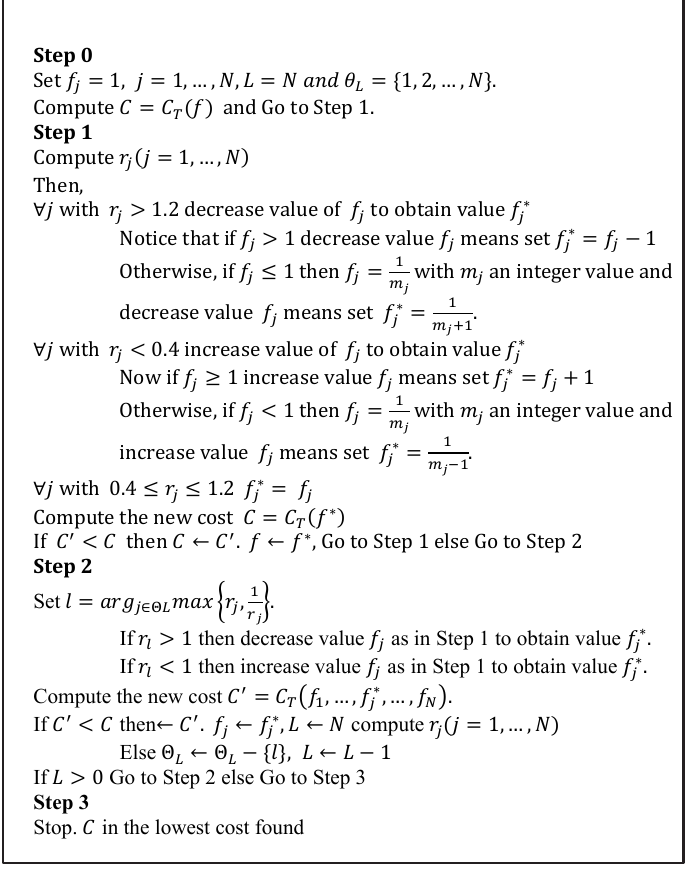
Fig. 2. Abdul-Jalbar heuristic. Source: (Abdul-Jalbar et al.,